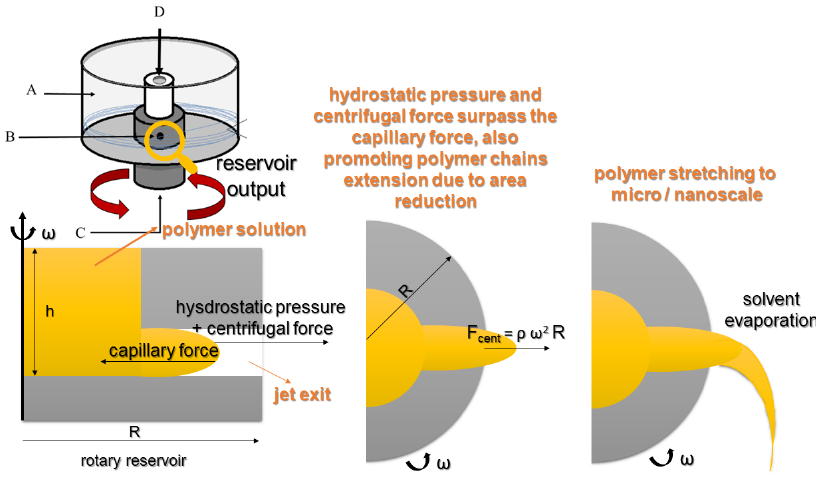
Figure 4. Polymer molten jet formation in the RJS apparatus (modified with permission from [74], Copyright 2018, IOP Publishing Ltd.).